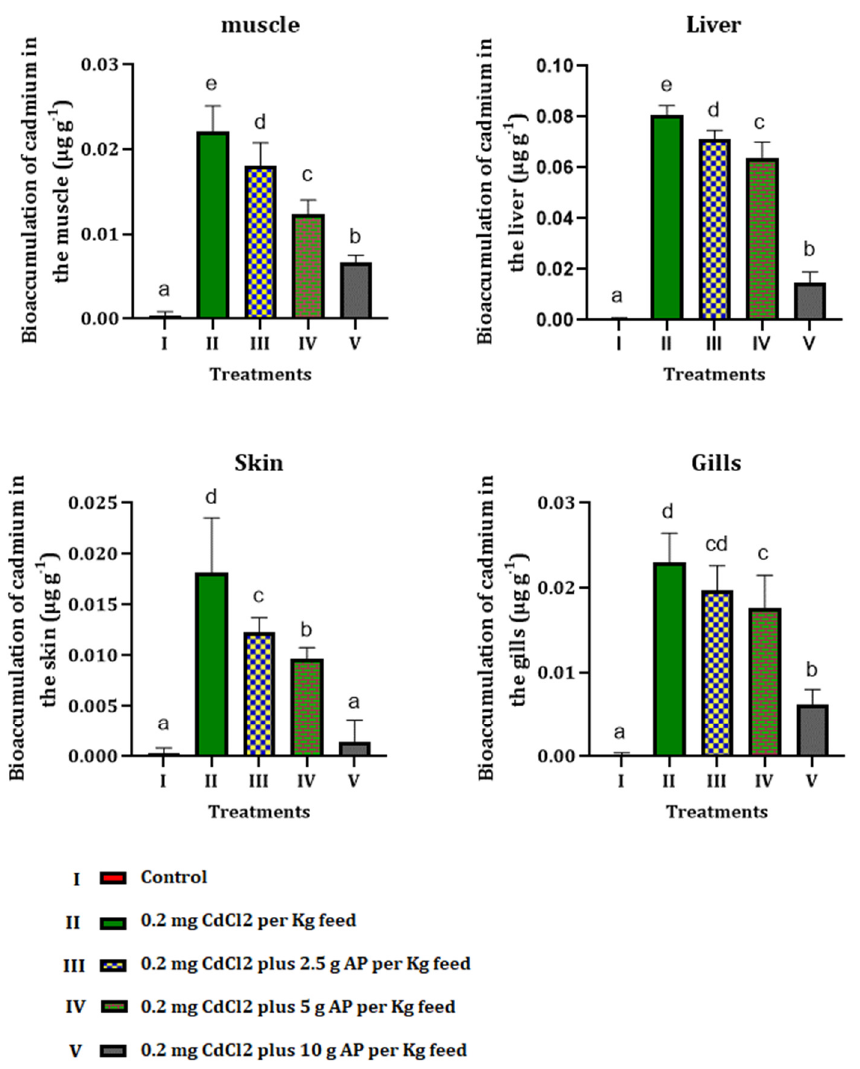
Figure 2. Bioaccumulation of cadmium in different tissues of fish orally exposed to CdCl 2 and Arthrospira platensis . Different letters show significant changes in values ( p < 0.05) and ( p < 0.01), and the same letter by different numbers shows there was no significant difference between the experimental groups.